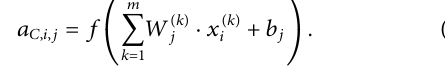
Frontiers in Energy Research |